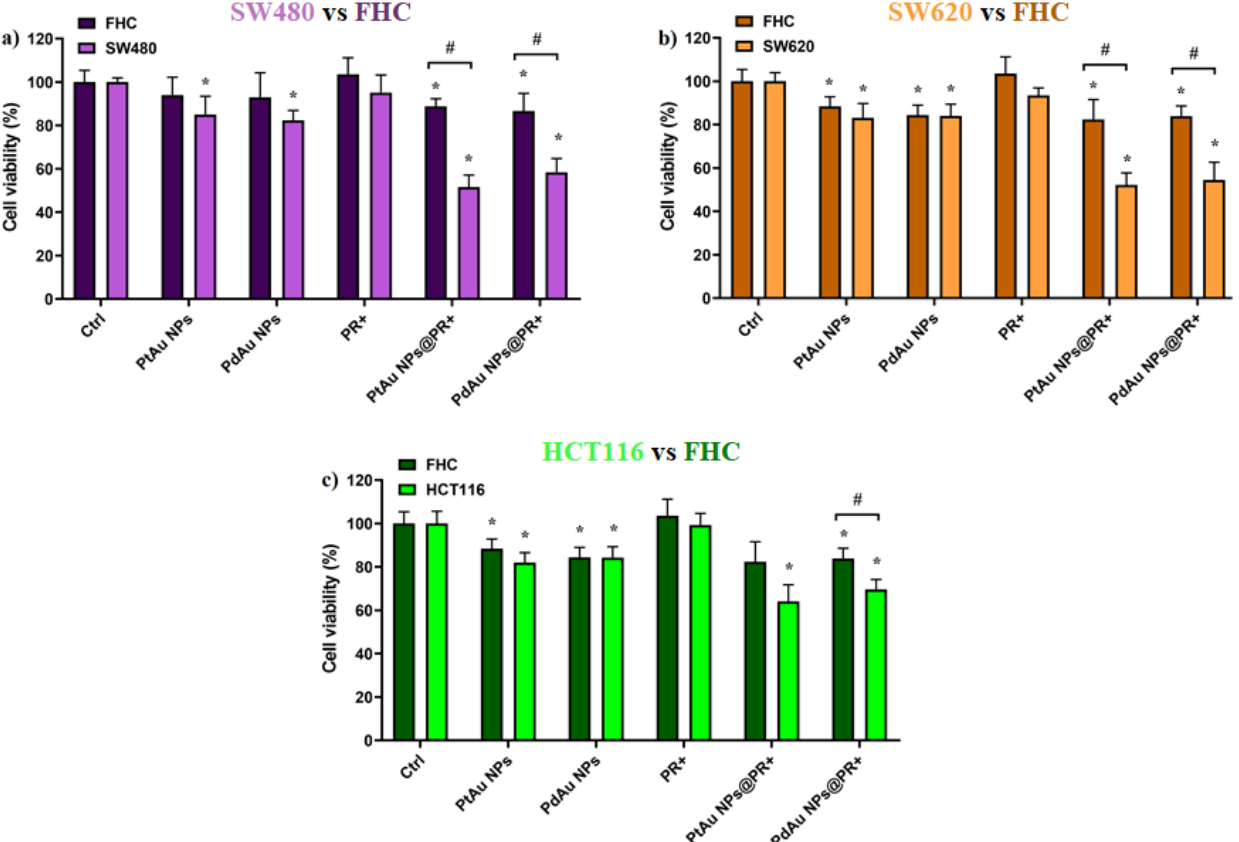
Figure 7. Viability of colon cancer cells ( a ) SW480, ( b ) SW620, and ( c ) HCT116 compared to FHC normal cells after the addition of PtAu/PdAu NPs and subsequent proton beam irradiation with a total dose of 15 Gy combined with PtAu/PdAu NPs. Data were considered significant if * p < 0.05 vs. control; # p < 0.05—statistically significant differences between the respective cancer lines and the normal FHC line.